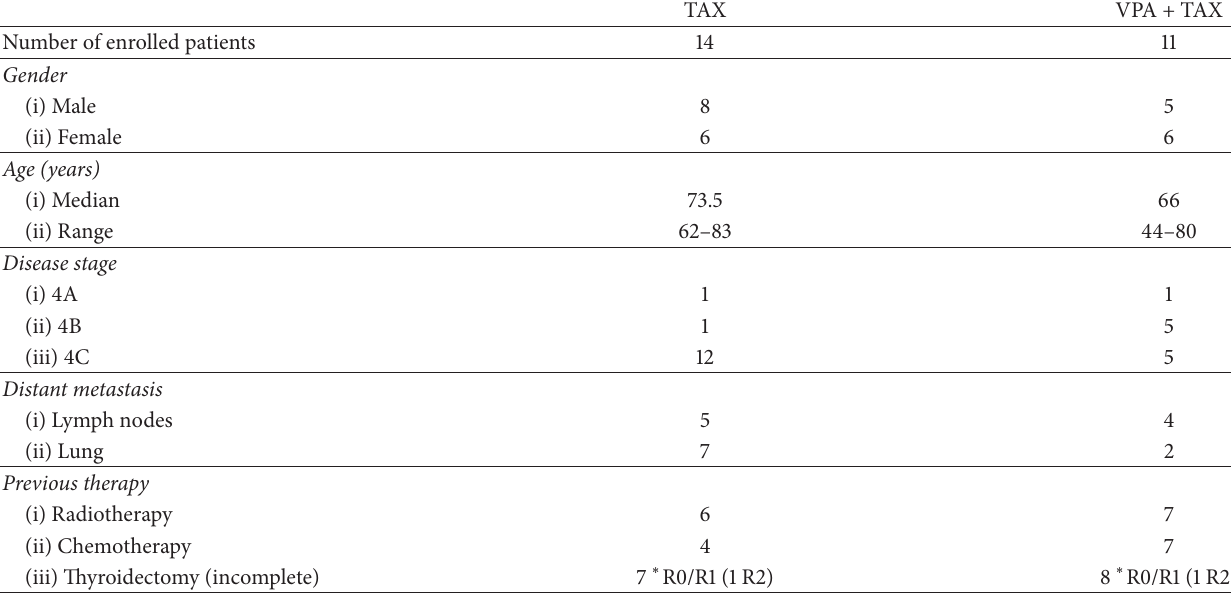
Table 1: Patient characteristics.